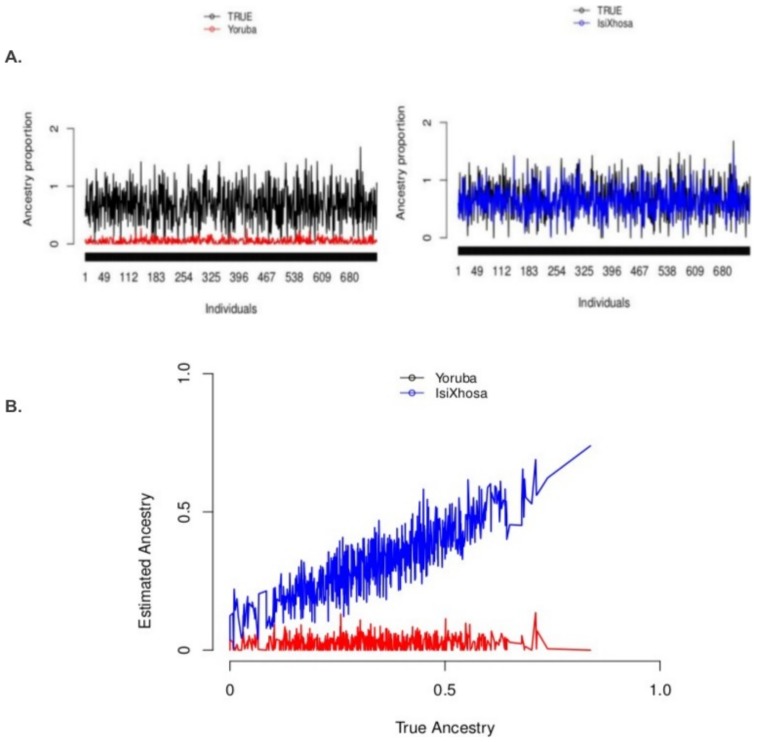
Comparison of true individual admixture proportions versus those estimated using appropriate and inappropriate proxy ancestry.(A) Plot of the estimated individual’s ancestry from best proxy ancestry (IsiXhosa:blue) and the true individual’s ancestry from the 750 admixed individuals (Black) obtained from the simulation. Plot of inappropriate proxy ancestry (Yoruba:red) estimated individual’s ancestry and the true individual’s ancestry from the 750 admixed individuals (Black) obtained from the simulation (see Materials and Methods). (B) Plot of the true ancestry versus the estimated individual’s ancestry from best proxy ancestry (IsiXhosa) and the estimated individuals ancestry from inappropriate proxy ancestry (Yoruba).